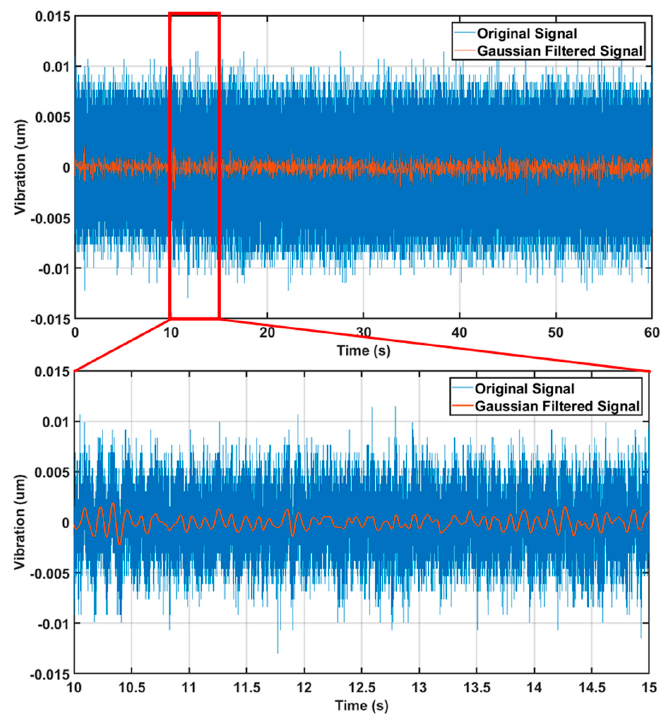
Figure A1. Static test of the capacitance probe.